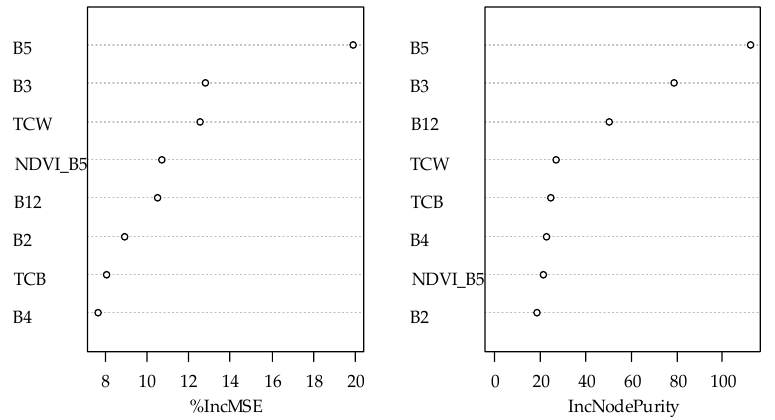
Figure 5. Plots of the selected variable importance. (left) %IncMSE, and (right) IncNodePurity. For the MLR algorithm, 14 out of the 24 variables were eliminated by the “redun” function to avoid multicollinearity; these eliminated variables were NDVI_B8, EVI2, SAVI, NDVI_B7, B7, B8A, TCB, NDVI_B6, B6, B3, B11, TCG, NDVI_B8A, and B4. The remaining variables were reselectedusing the P significance in linear modeling. Finally, B5 and MSI were selected for the MLR model.